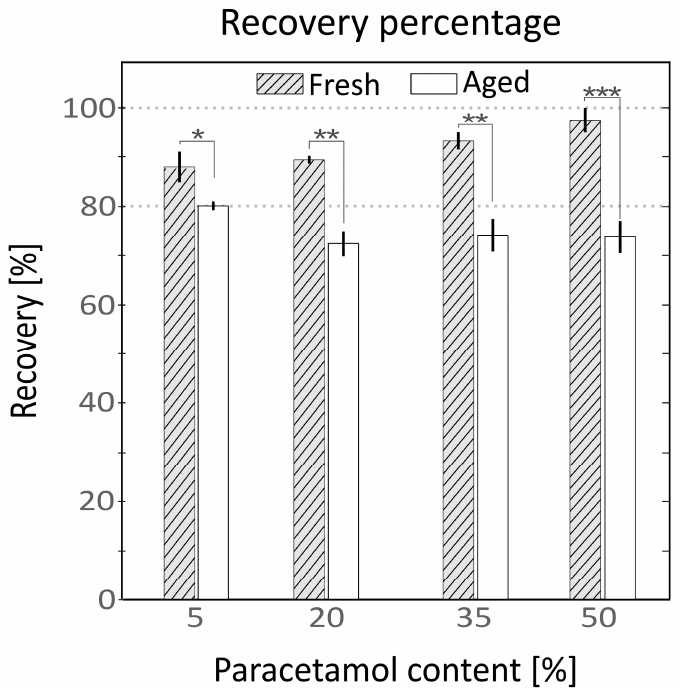
Figure 4. Recovery percentages of samples containing 5% of Guar gum tested in fresh condition (grey stripped) and aged for 6 weeks at room temperature (solid white). Horizontal axis represents the API percentage and vertical axis the % rate of recovery measured with HPLC-DAD (mean ± SD, n = 3, * p < 0.05, ** p < 0.01, *** p < 0.001).